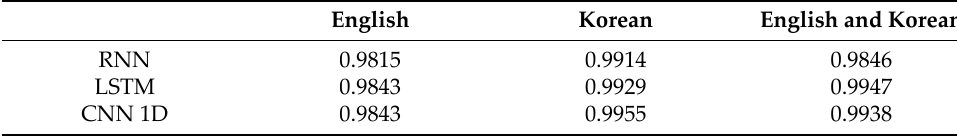
Table 6. Performance of each model accuracy per dataset.